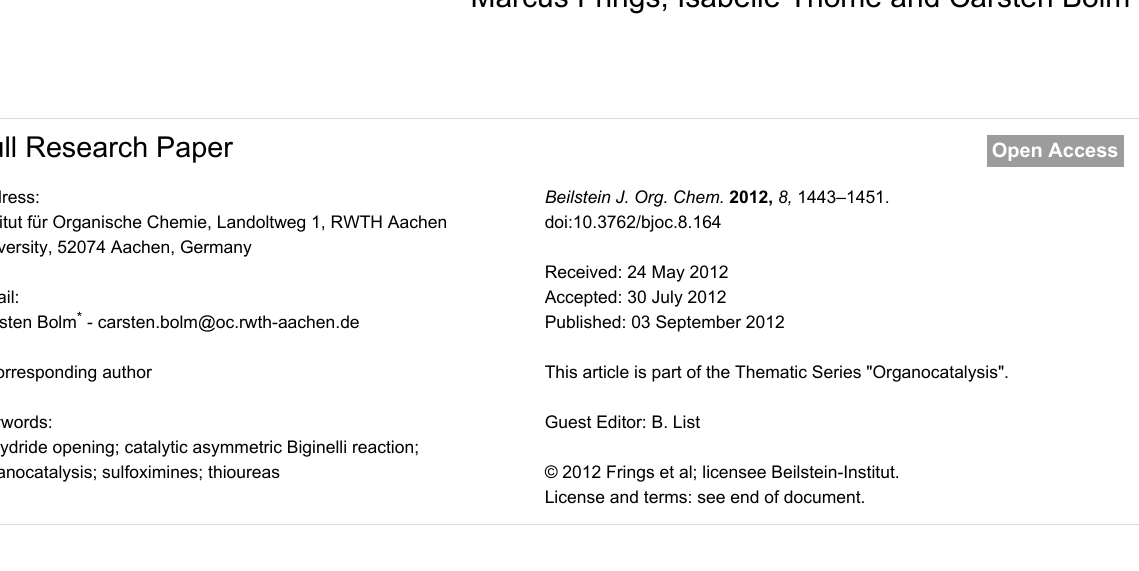
Being monoaza analogs of sulfones, sulfoximines have